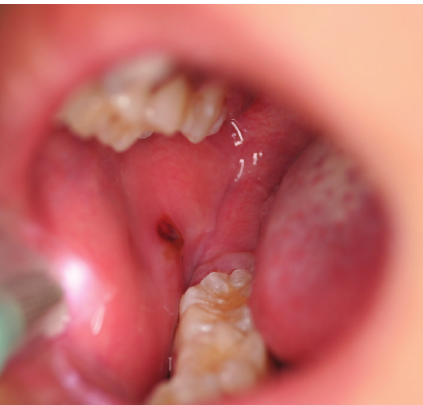
Figure2:Localizedbuccalmucositisinapatientwithosteosarcoma.